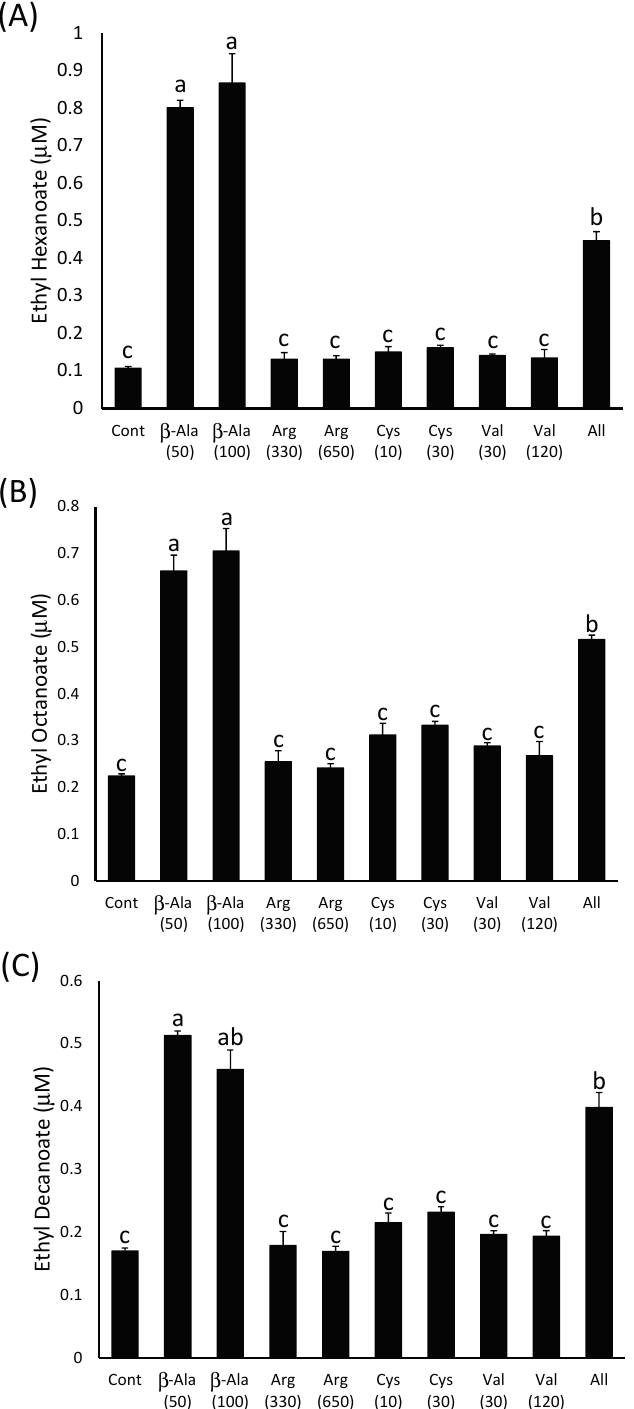
Figure 4. The concentration of ( A ) ethyl hexanoate, ( B ) ethyl octanoate and ( C ) ethyl decanoate in model wines produced after the addition of amino acids as indicated on the x-axis. The number in brackets represents the concentration added in mg·L − 1 . Histograms represent the mean values (n = 3) and error bars show standard errors. Different letters (e.g., a, b, c) denote significant differences between treatments at p < 0.05 using ANOVA followed by Tukey’s post hoc